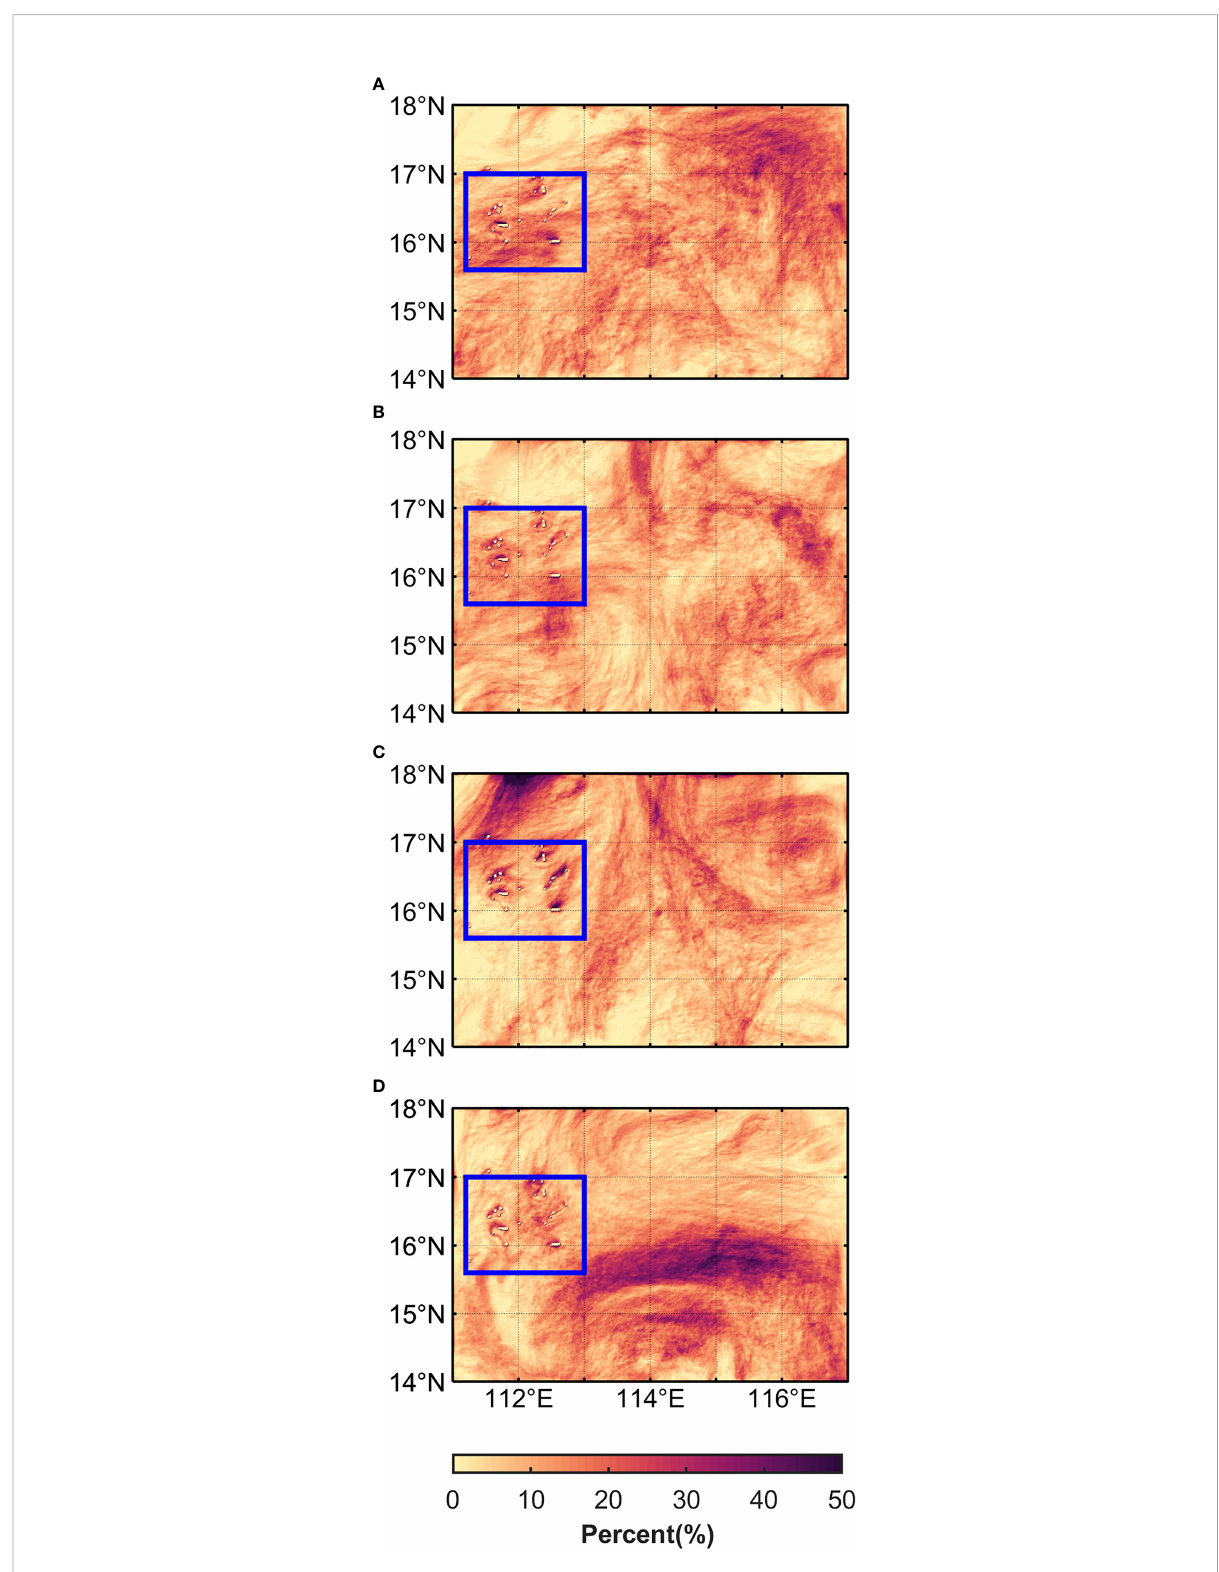
FIGURE 4 Probability distribution of SI activity in January (A) 2017, (B) 2018, (C) 2019 and (D) 2020. Inside the blue rectangle are the Xisha Islands. SI, symmetric